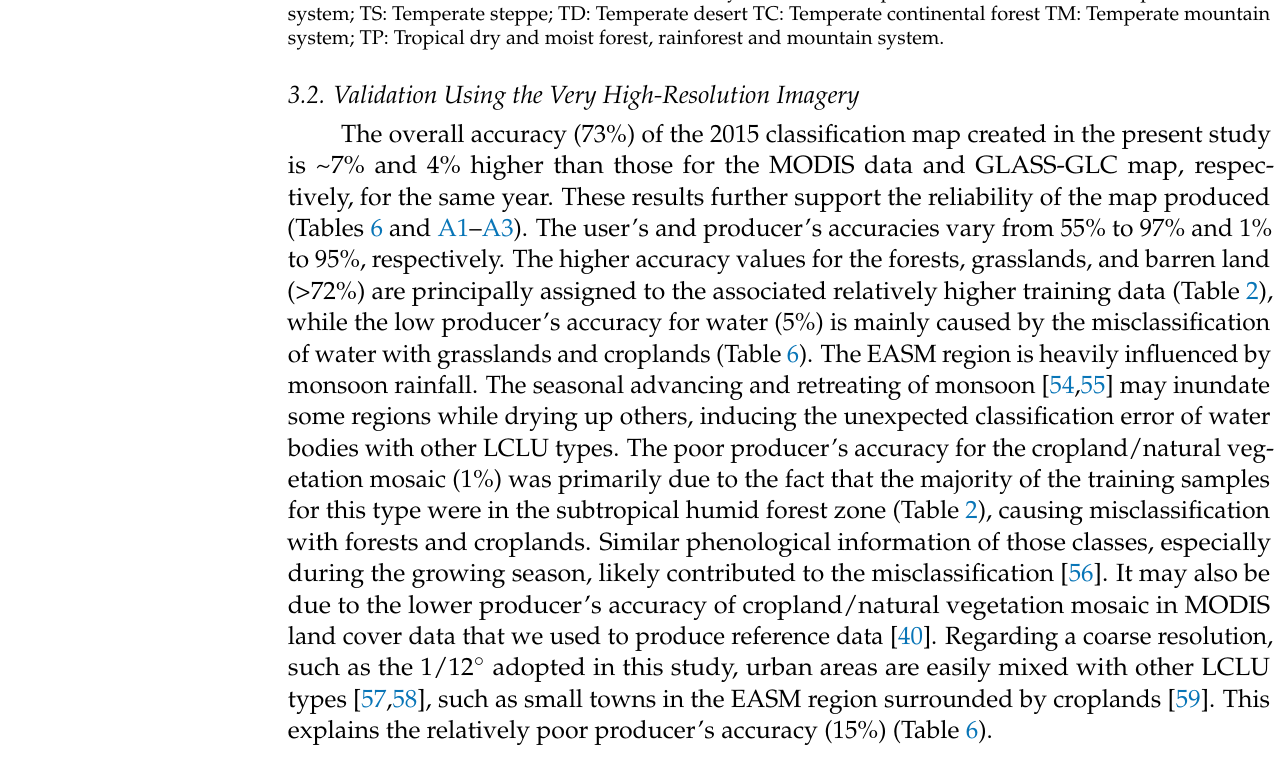
Table 6. Validation for classified map in 2015 using very high-resolution